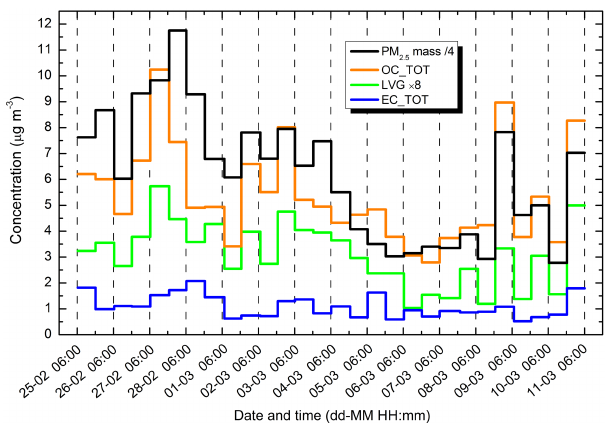
Figure 1. Temporal variability of the atmospheric concentrations for the PM 2 . 5 mass, EC and OC determined by the laboratory OC / EC TOT method (EC_TOT, OC_TOT, respectively) and lev- oglucosan (LVG) for the sample collection periods of the 2 × 14 daylight times and